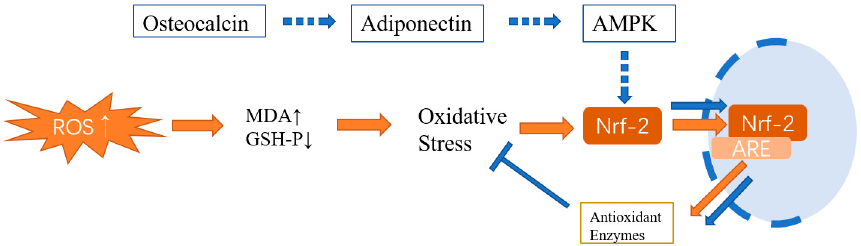
Figure 4. The diagram depicting the osteocalcin effect on regulating the Nrf-2 signaling pathway in the liver with FLHS.